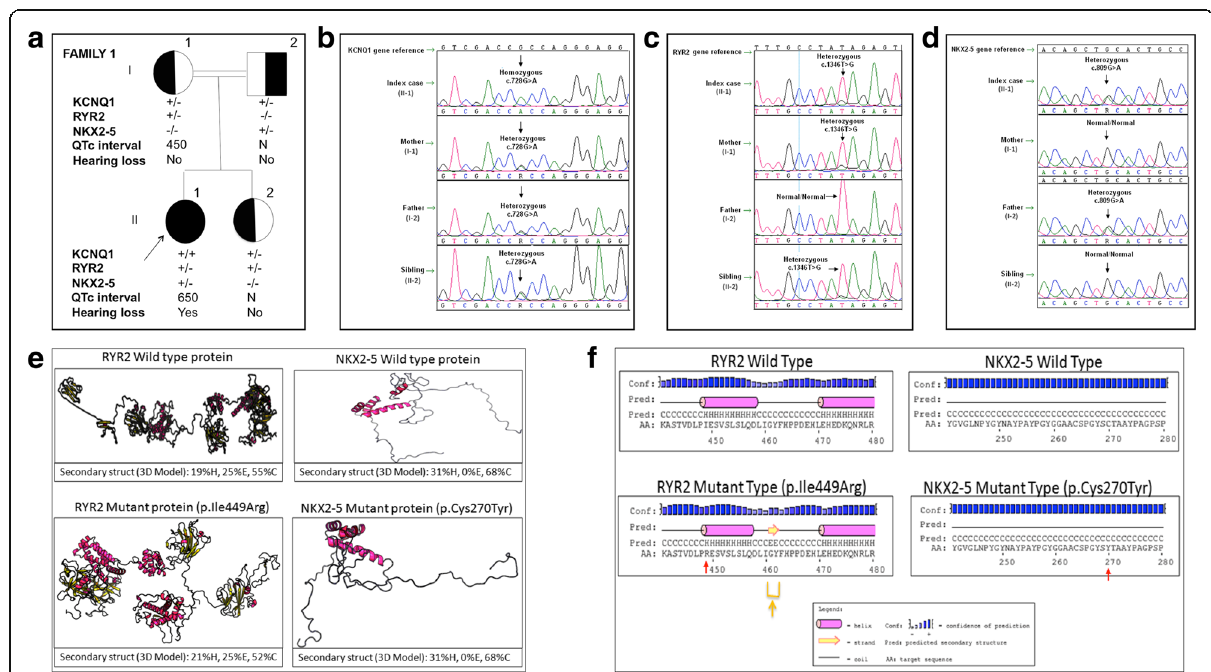
Fig. 1 The molecular and clinical findings for family I ( a ) Pedigree of the family I; Case 1 (II-1) who is carrying homozygous c.728G > A (p.Arg243His) mutation in the KCNQ1 gene, heterozygous c.1346 T > G (p.Ile449Arg) alteration in RYR2 gene and heterozygous c.809G > A (p.Cys270Tyr) alteration in NKX2 – 5 gene and the carrier status of the other family members were shown in the fig. (N: Normal, +: Mutant allele, − : Normal allele) ( b ) DNA sequencing image for KCNQ1 mutation ( c ) DNA sequencing image for RYR2 variant ( d ) DNA sequencing image for NKX2 – 5 variant ( e ) Predicted secondary structures and 3D modelling of wild type and mutant RYR2 protein (left) and NKX2 – 5 protein (right) (H: Helix, E: Beta Sheet, C: Loop). For 3-state secondary structure, It is predicted that the secondary structure of RYR2 mutant type is altered when compared to wild type and the secondary structure of NKX2 – 5 mutant type is not altered when compared to wild type ( f ) Predicted secondary structures of wild type and mutant RYR2 protein (left) and NKX2 – 5 protein (right). The altered residues of RYR2 (p.Ile449Arg) and NKX2 – 5 (p.Cys270Tyr) are shown with red arrows. It is predicted that the secondary structure of RYR2 mutant type is altered when compared to wild type (shown with orange arrow) and the secondary structure of NKX2 – 5 mutant type is not